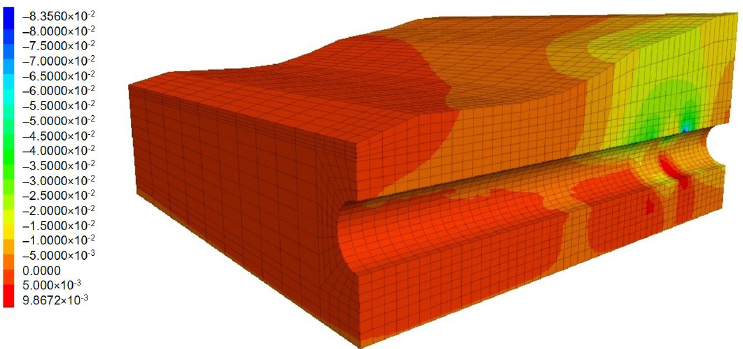
Figure 15. Computed settlement at the last episode (in